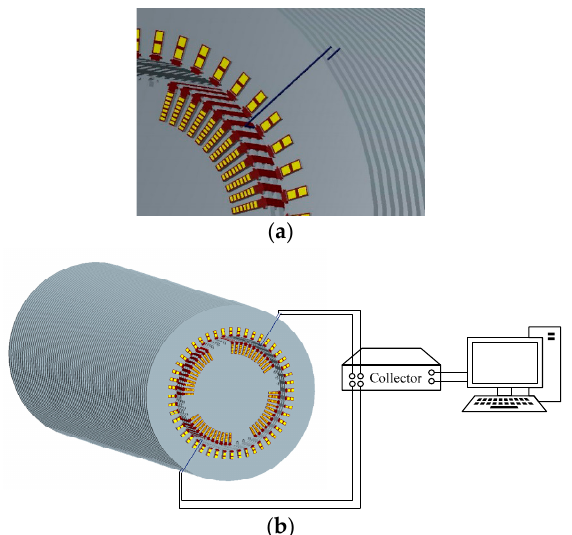
Figure 3. Schematic diagram of the detection system: ( a ) Structure of a single coil; ( b ) Online detection system.